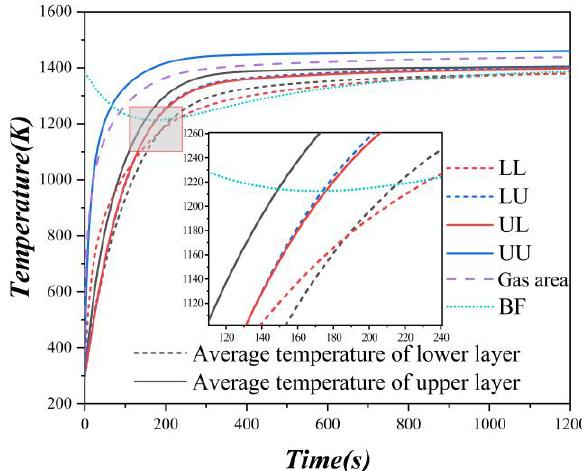
Figure 8. Temperature variations with reduction time at di ff erent bed locations. Figure 8 . Temperature variations with reduction time at different bed locations.